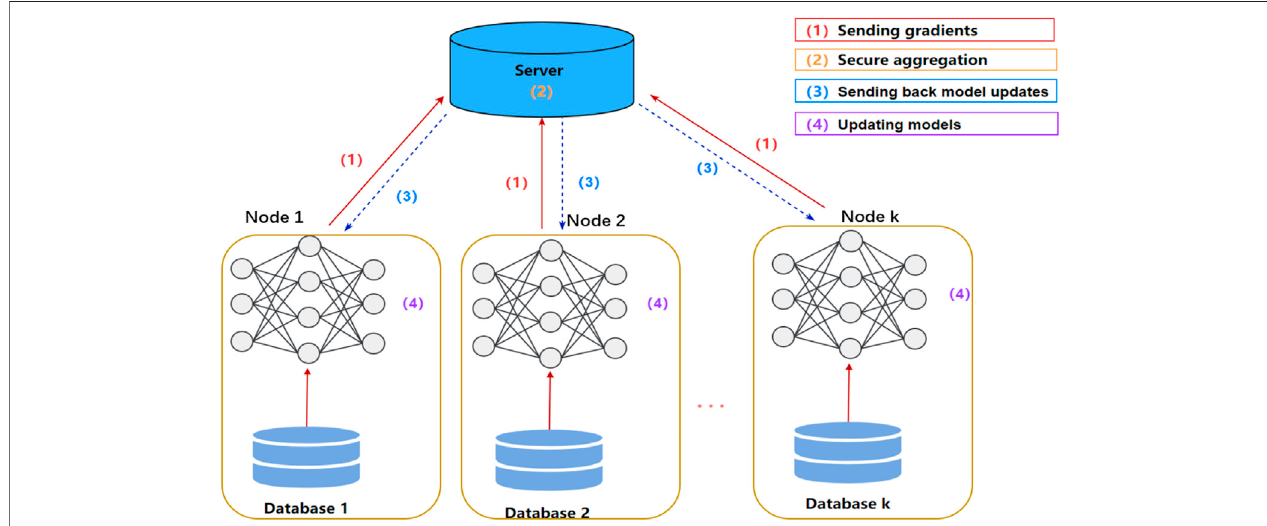
FIGURE 1 | Distributed machine learning architecture. In this scheme, the whole dataset is divided into subsets and stored distributedly on nodes. Each node has the complete model but only works with part of training data. The central server aggregates the parameter from each node ’ s information of each local model and transfers the global parameters to the local model to guide the model training. Then, if the performance of the new global model is still not satisfactory enough, a new round of training can be started.